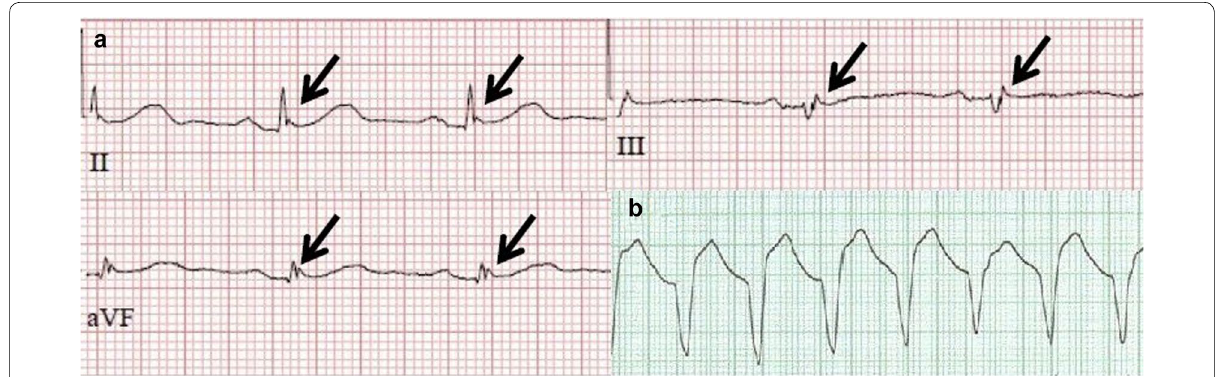
Fig. 1 Baseline ECGs in TTC patients. ( a ) Notched elevation (arrows) in inferior leads (II, III, aVF) in patients who experienced an event of monomorphic ventricular tachycardia ( b )